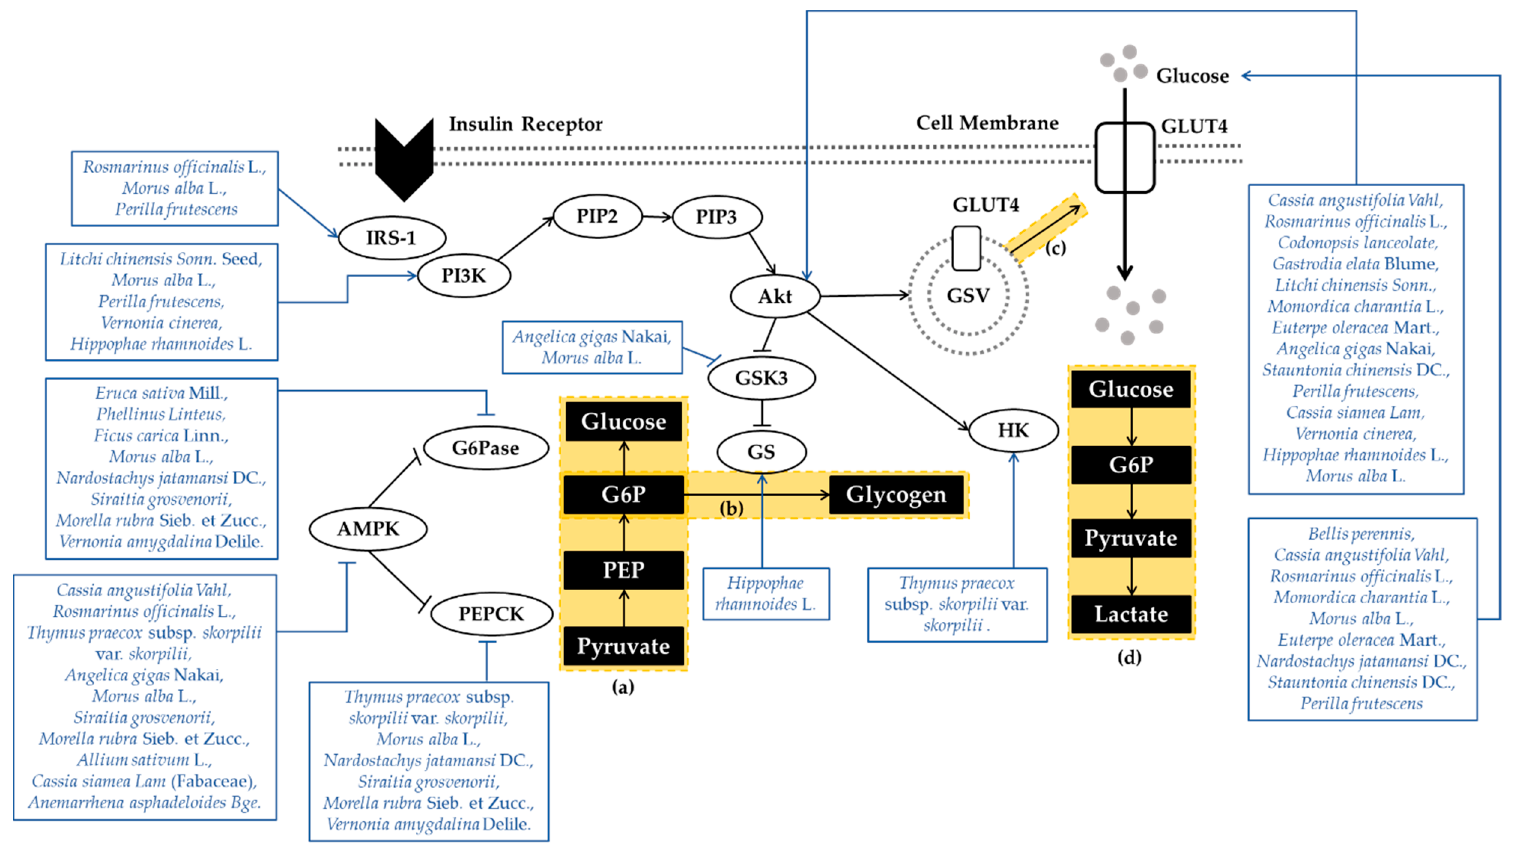
Figure 1. Schematic Diagram of Glucose Transport and Metabolism. Glucose transport and metabolism is associated with the activation of GLUT4 as well as various enzymes such as G6pase, PEPCK, GS, and HK. The PI3K/Akt pathway and the activity of AMPK play an essential role in glucose homeostasis. Numerous plant extracts regulated glucose metabolism in type 2 diabetes by regulating the expression of such factors. ( a ) Gluconeogenesis, ( b ) glycogen synthesis ( c ) glucose translocation, ( d ) glycolysis. (IRS-1, Insulin receptor substrate 1; PI3K, Phosphoinositide 3-kinase; PIP2, Phosphatidylinositol-4,5-bisphosphate; PIP3, Phosphatidylinositol-3,4,5-triphosphate; Akt; Protein kinase B; GSK3, glycogen synthase kinase 3; GS, glycogen synthase; G6Pase; Glucose-6-phosphatase; AMPK, Adenosine 5 ′ -monophosphate-activated protein kinase; PEPCK, Phosphoenolpyruvate carboxykinase; GLUT4, Glucose transporter; GSV, Glut4 storage vesicle; HK, Hexokinase; G6P, Glucose 6-phosphate; PEP, Phosphoenolpyruvate.)